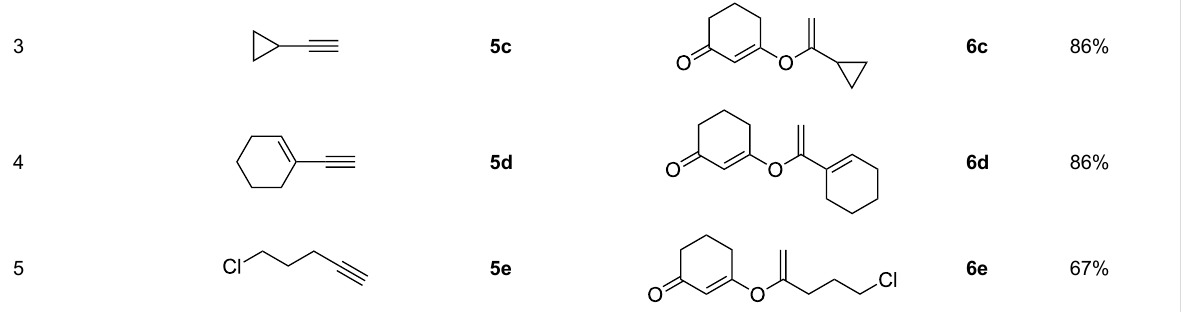
Table 3: Reaction scope with aliphatic alkynes. a (continued)